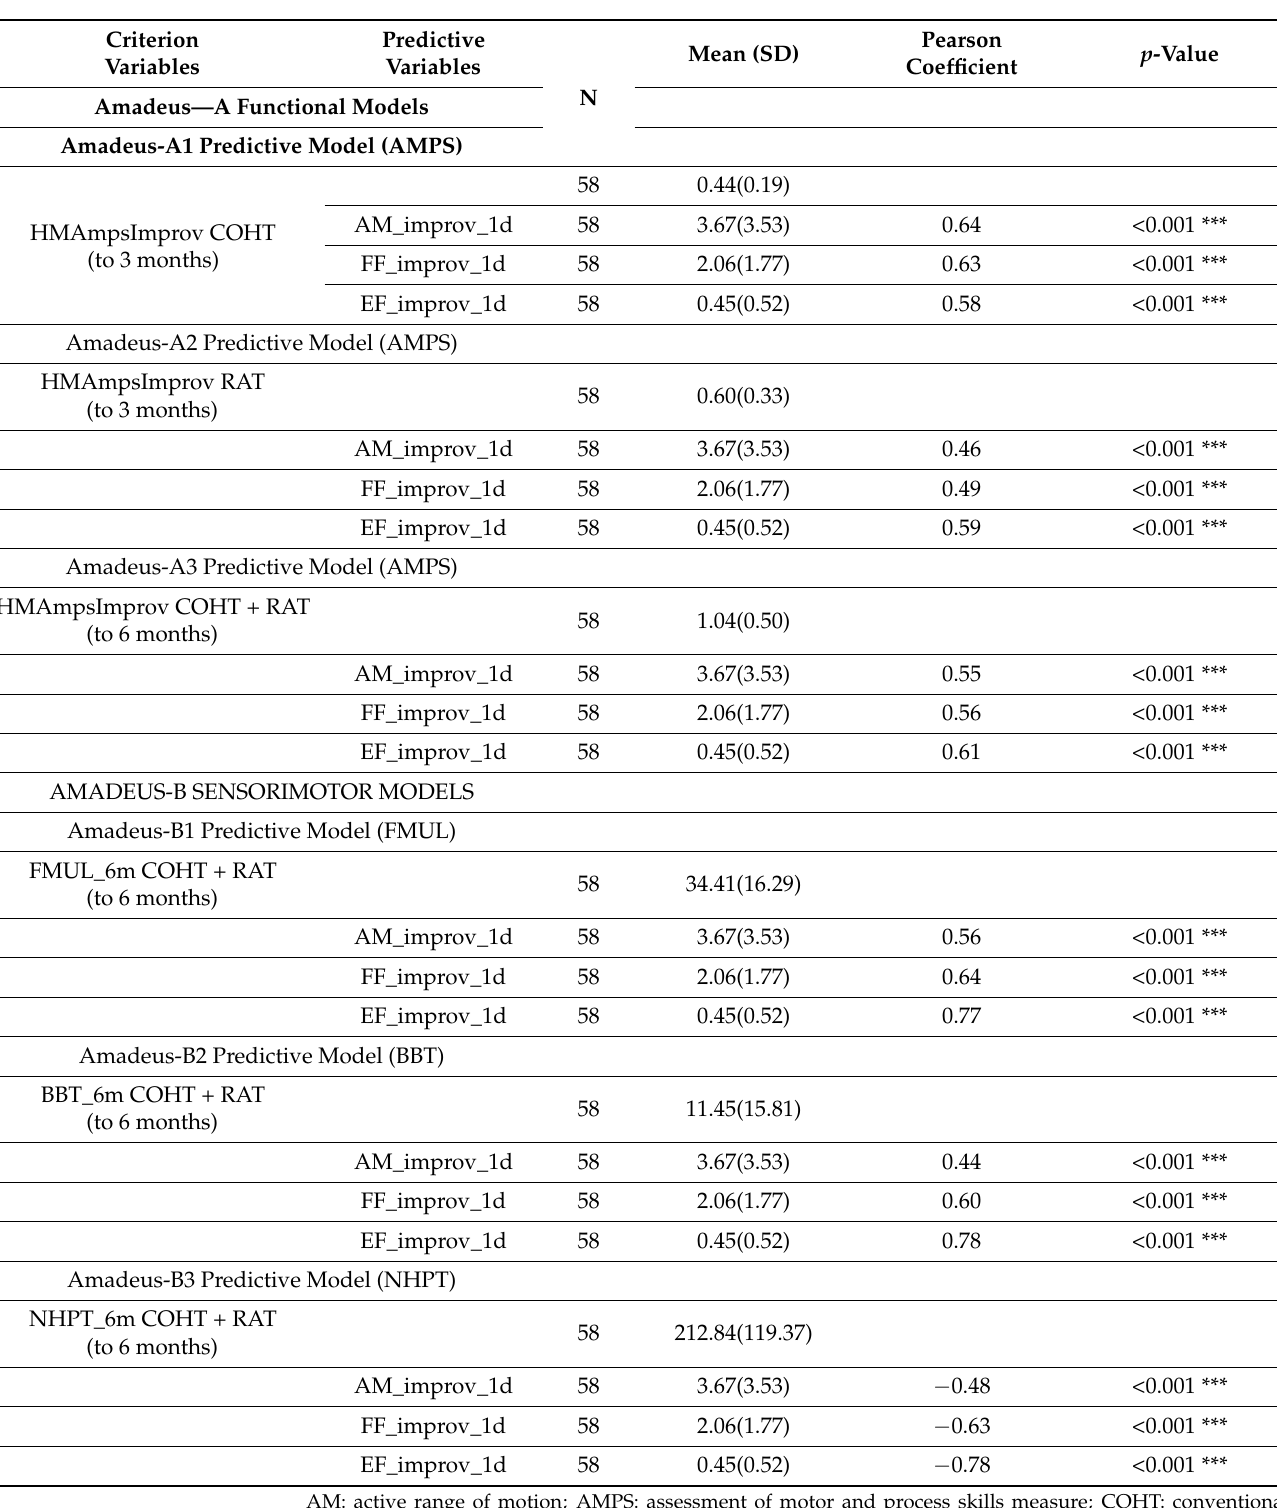
Table 4. Parametric correlations between criterion and predictor variables for the Amadeus-A and Amadeus-B regression